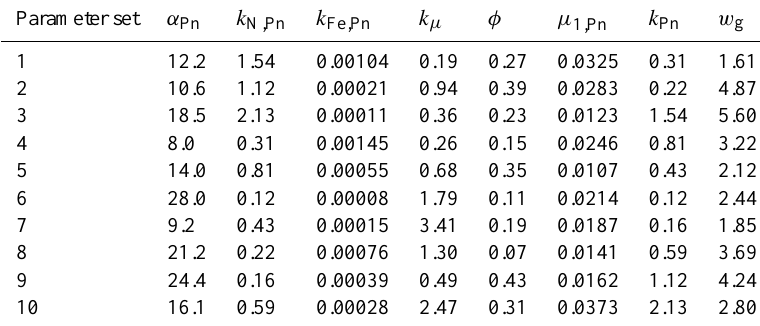
Table 2. Representative sample from 8-dimensional MEDUSA parameter space. Parameter